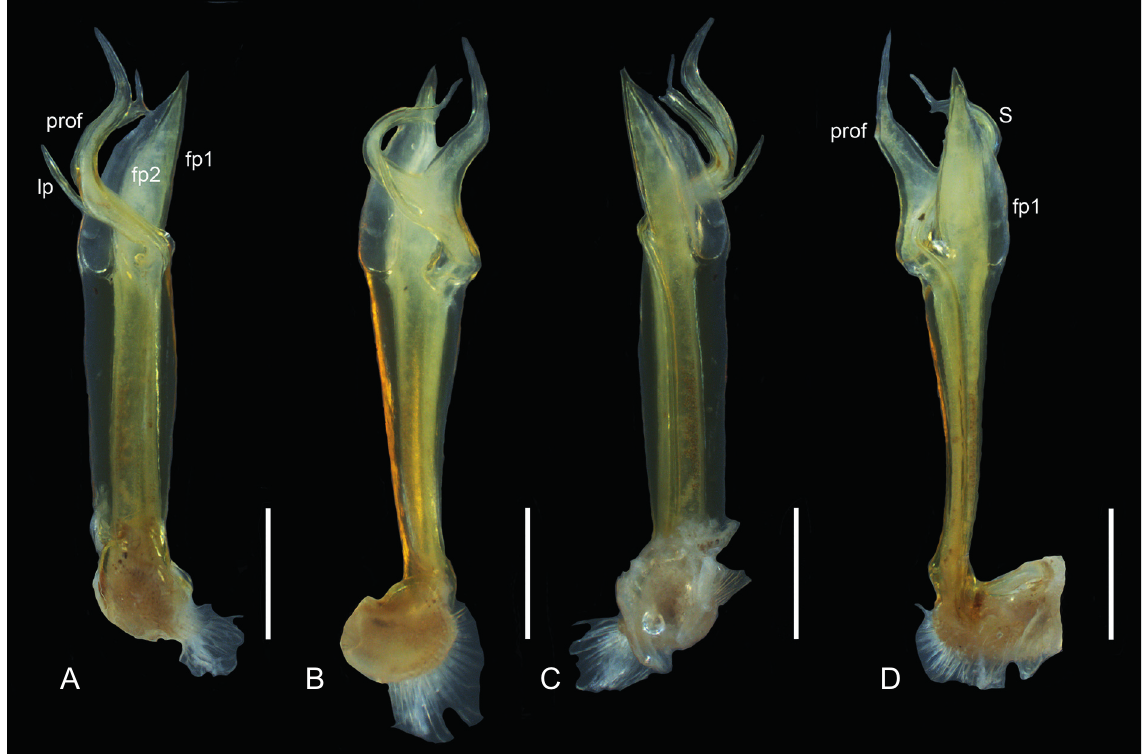
Fig. 13. Pogonosternum adrianae Jeekel, 1982, male, right gonopod (NMV K-10719). A . Posterior view. B . Lateral view. C . Anterior view. D . Mesal view. Scale bars = 0.5